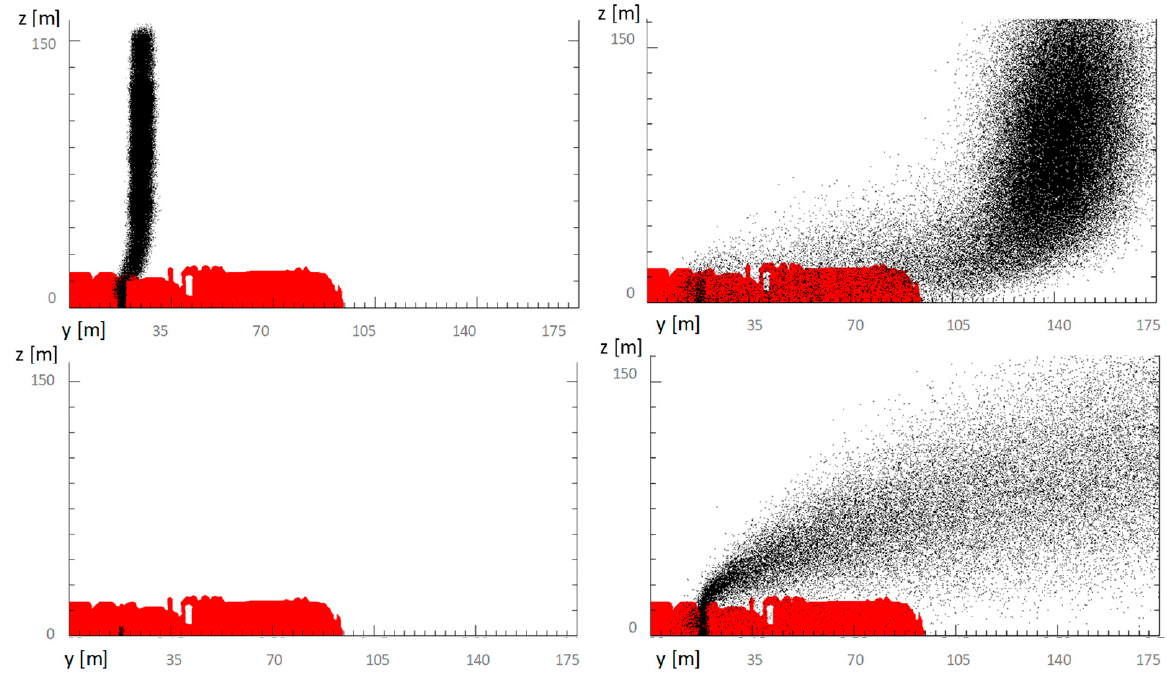
Figure 4. Column of particulate matter from explosion between 10 s and 150 s (in red) vs. cloud of smoke from the fire between 5 s and 10 min (in black). Table 6. Comparison of the two simulations (detonation vs. fire), reporting the shape and concentra- tion values of the radioactive